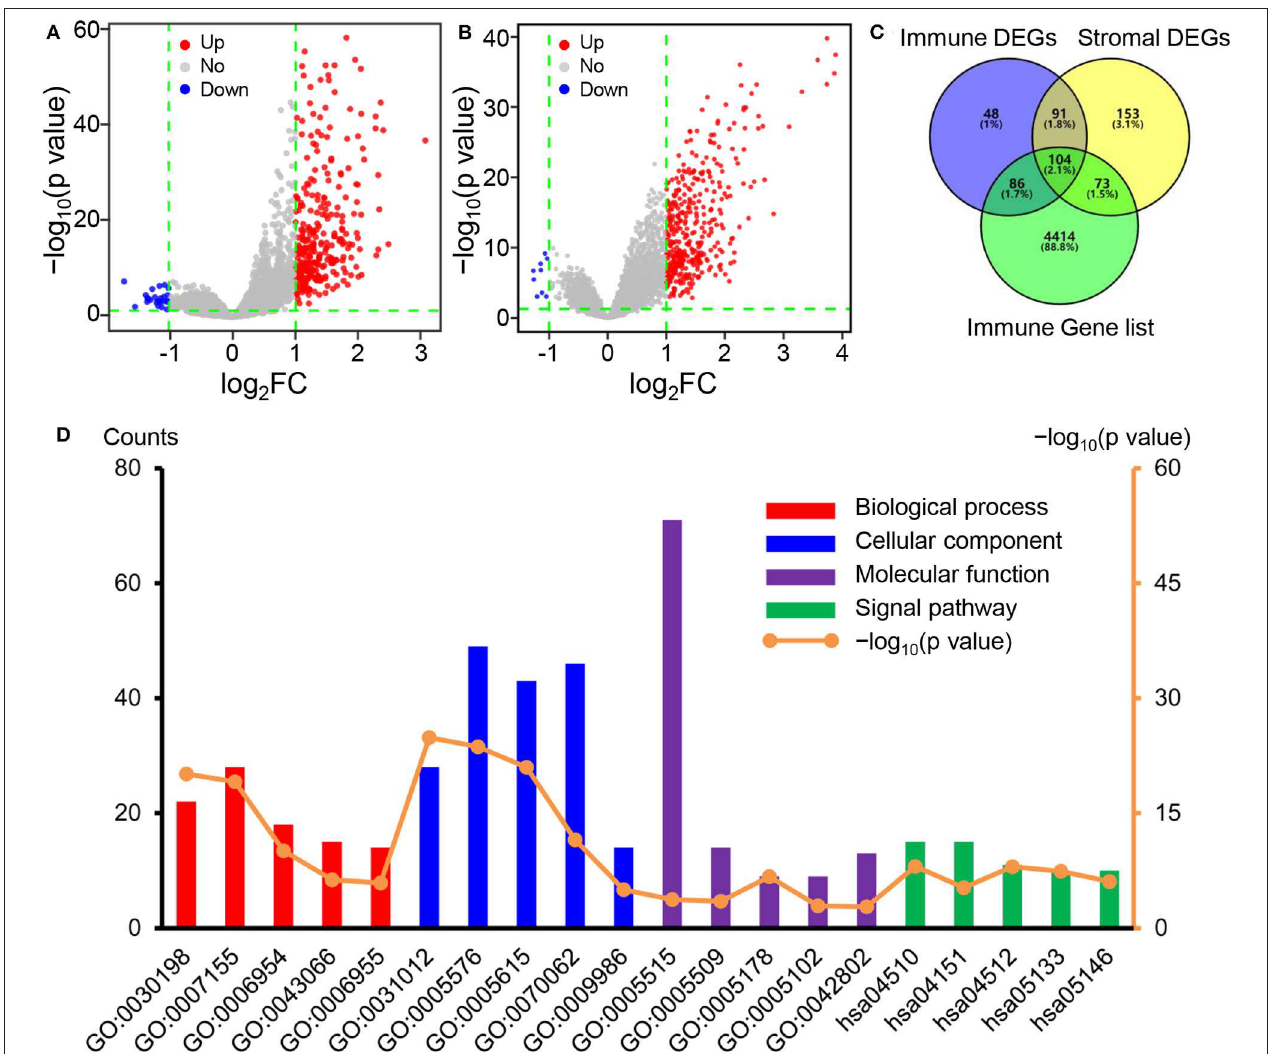
FIGURE 3 | Identification of DEGs and functional enrichment analyses. (A) Volcano plot of DEGs based on immune score in BC samples. (B) Volcano plot of DEGs based on stromal score in BC samples. (C) Venn diagrams showing the overlapping genes among immune score-related DEGs, stromal score-related DEGs, and immune function-related genes. (D) The top five GO and KEGG pathway terms of the overlapping immune-related DEGs. DEGs, differentially expressed genes; BC, bladder cancer; GO, Gene Ontology; KEGG, Kyoto Encyclopedia of Genes and Genomes.